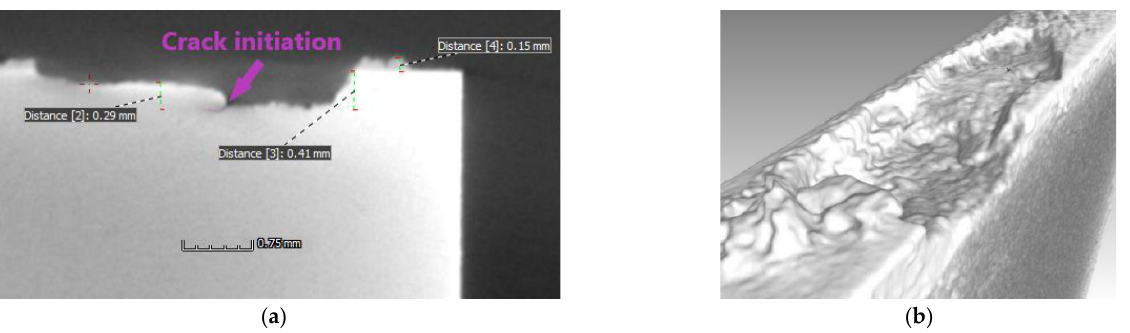
Figure 9. Fracture obtained in brittle area after mechanical testing (CoCr part): ( a ) CT section; ( b ) virtual reconstruction.